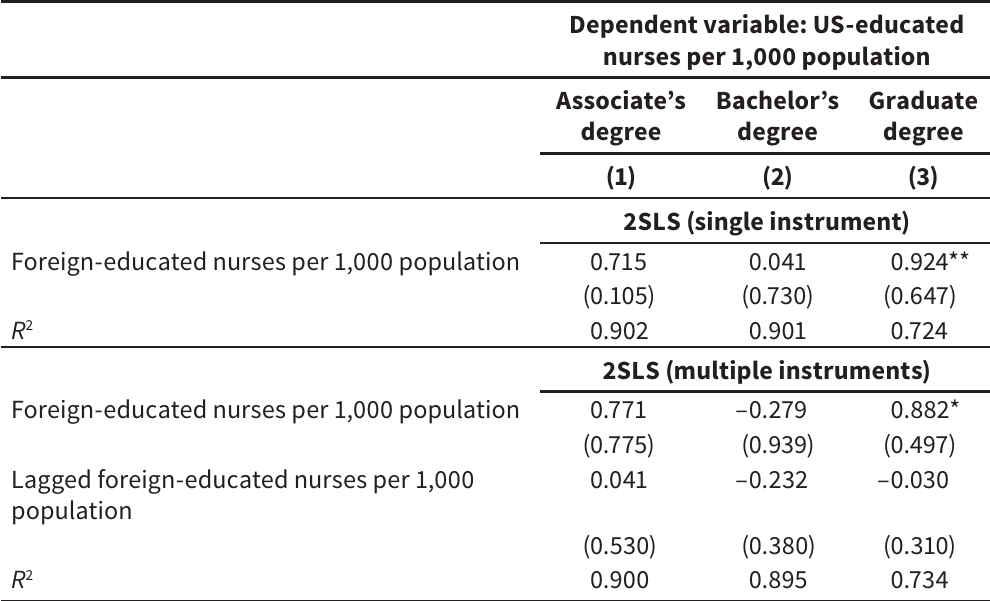
Displacement effects of the foreign-educated RNs on US-educated RNs by education,